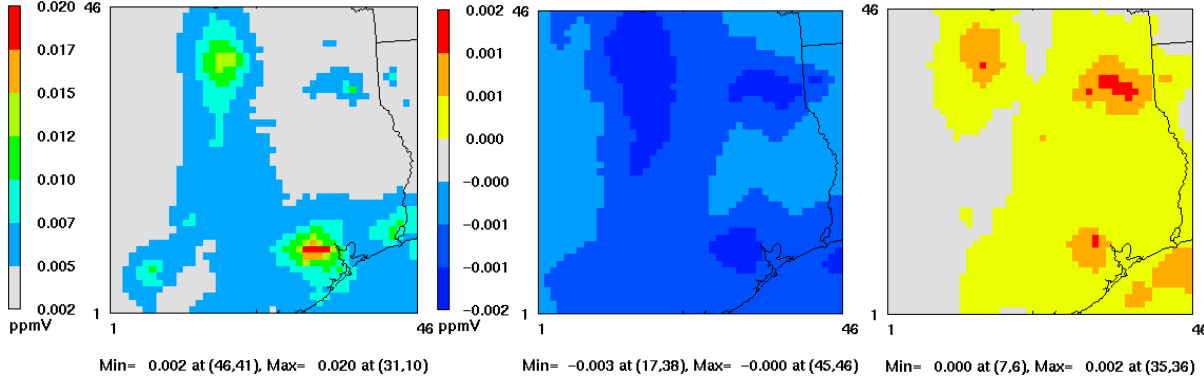
Figure 9. Monthly 8h (10:00–18:00LT) averaged ground O 3 concentrations (top), O 3 sensitivity to NO x (middle), and O 3 sensitivity to VOC (bottom) for the a priori case (left), and differences between a posteriori and a priori for the sector-based DKF inversions case I (middle) and case II